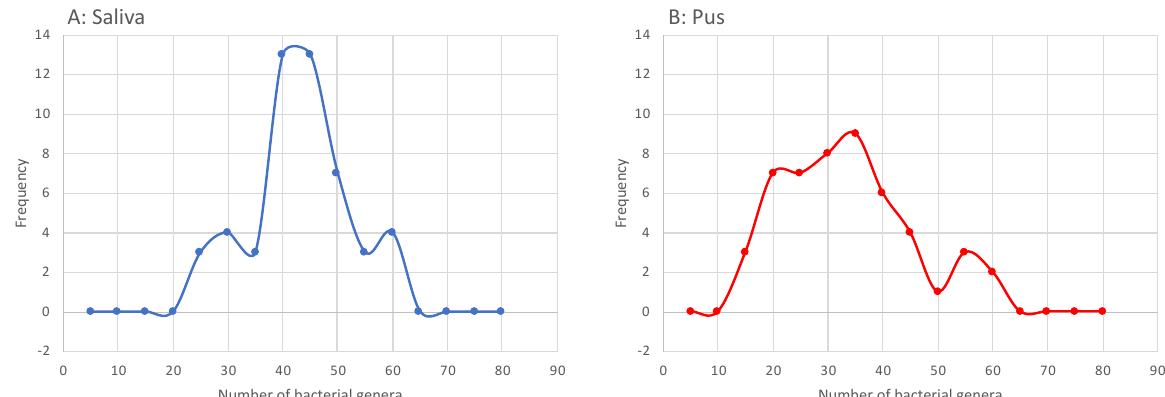
Figure 2. Histogram of the counted bacterial genera in the saliva ( A ) and the pus ( B ) to describe alpha diversity. The occurrence of a genus was counted if the genus contributed to at least 0.01% of the microbiome.